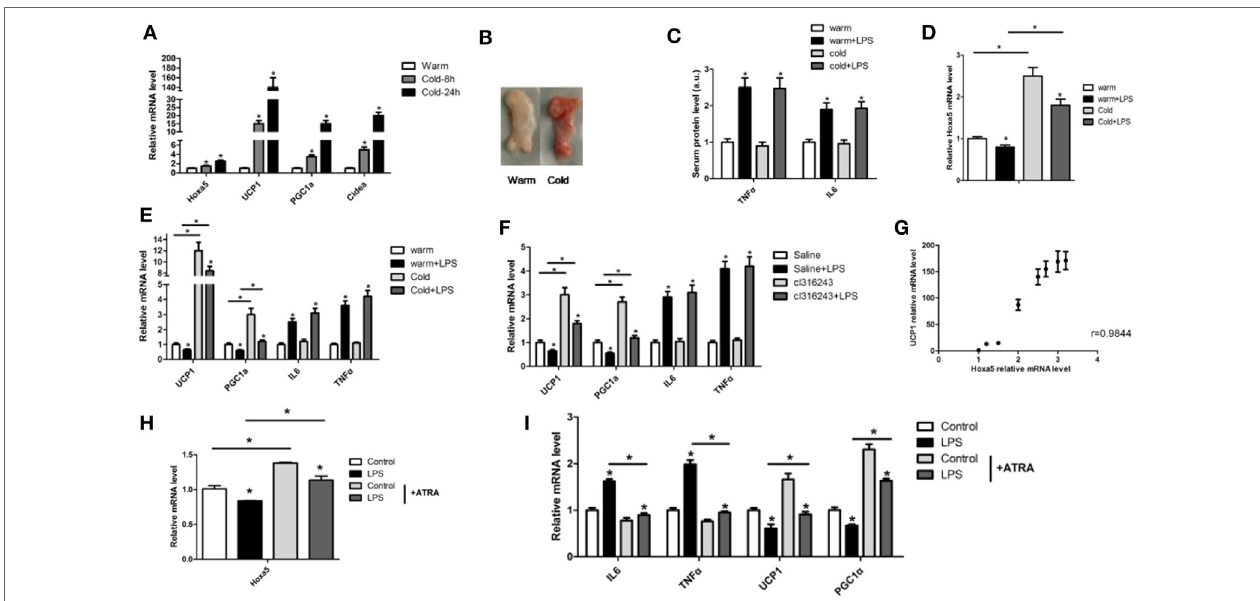
FigUre 3 | Homeobox a5 (Hoxa5) enhances white adipose tissue (WAT) browning by alleviating lipopolysaccharide (LPS)-induced inflammation in mice. (a) Relative mRNA levels of Hoxa5, UCP1, PGC1 α , and Cidea in inguinal white adipose tissue (iWAT) after 8 or 24 h cold exposure at 4°C ( n = 6). (B) iWAT